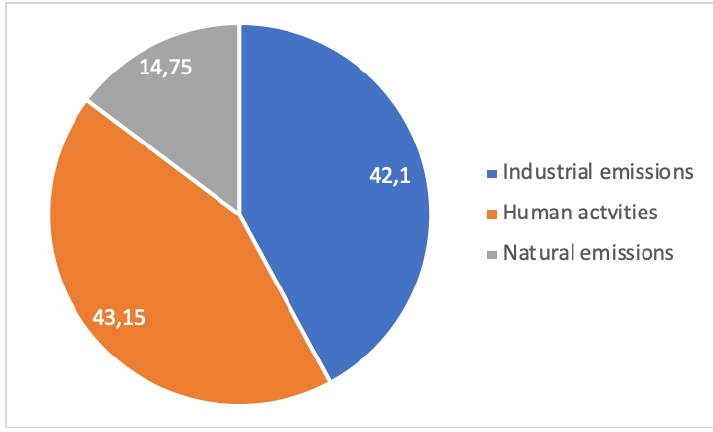
Figure 15. Local pollution in the Vitória metropolitan area: distribution of PM10 according to sources of emissions (adapted from [45])